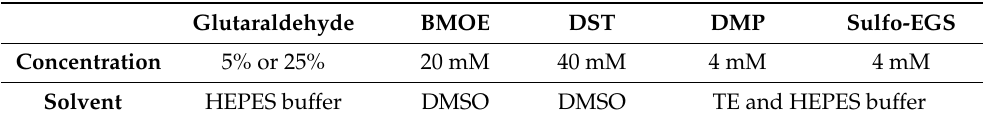
Table 2. Stock solutions for the cross-linking. The solutions of BMOE and DST were diluted with a mixture of TE and HEPES buffer to a final concentration of 2 and 4 mM,